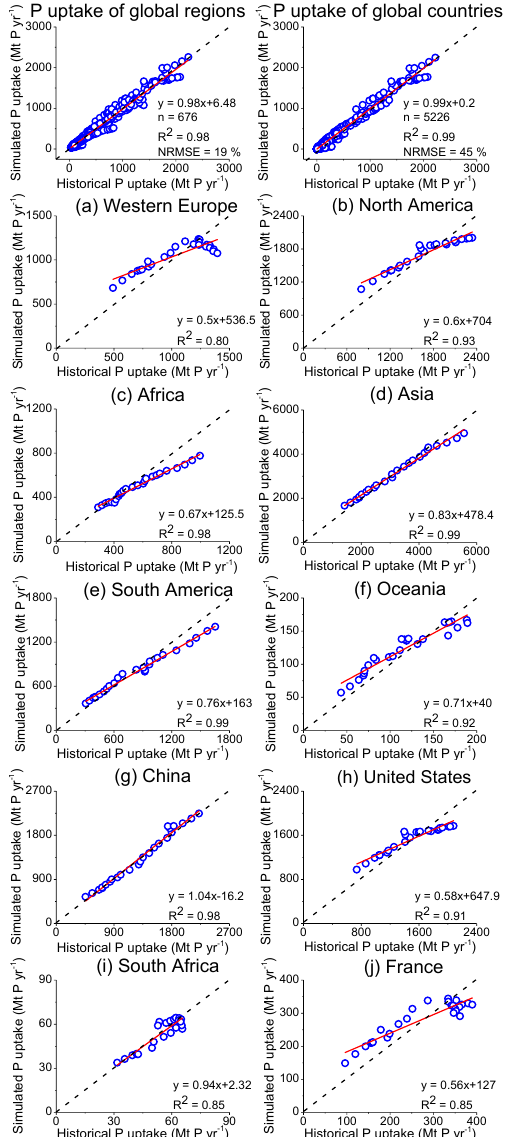
Figure 3. Relationship between simulated and historical P uptake for individual regions, countries, and the world, presenting results for every 2 years from 1961 to 2010. Dashed line is 1:1.